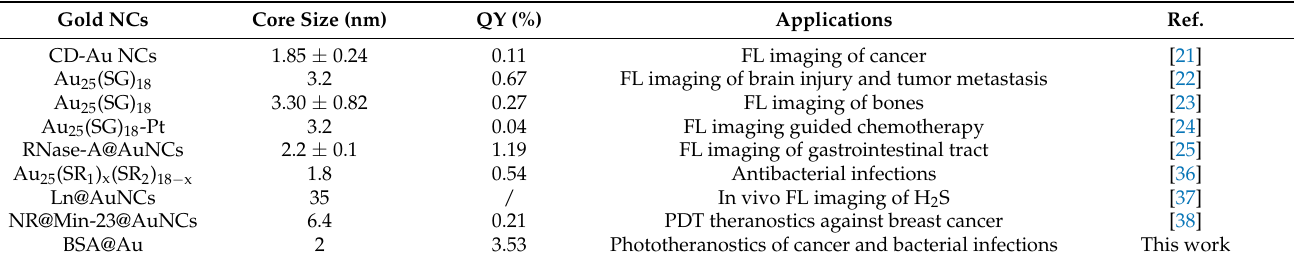
Table 1. Overview of NIR-II emissive gold